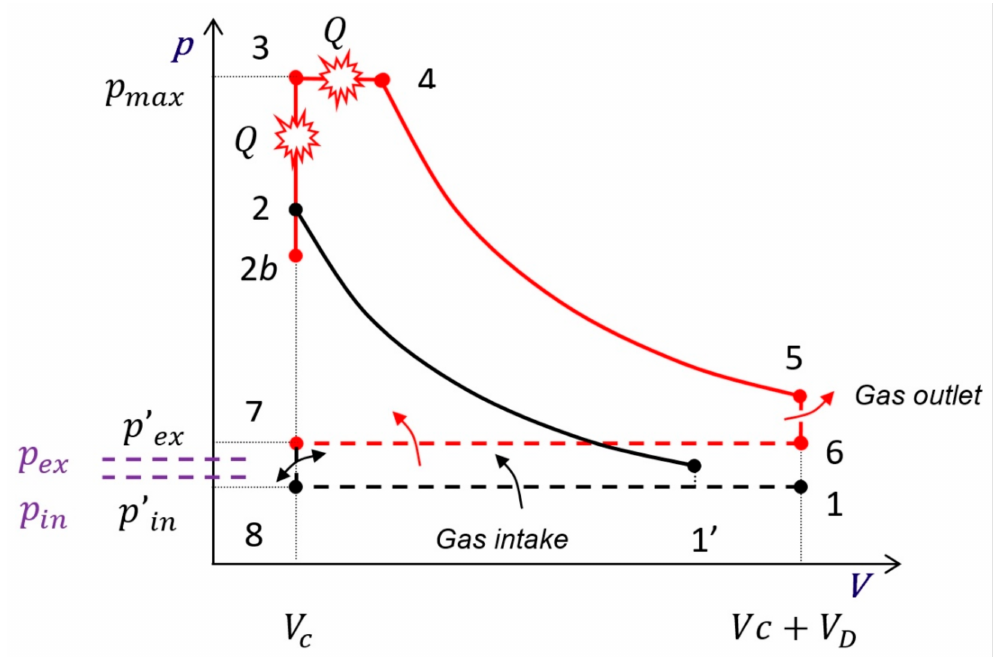
Figure 1. Dual open cycle in a p-V diagram. Black lines show unburned gas, while red lines show burned gas. Continuous lines show closed processes, and dashed lines show cylinder open